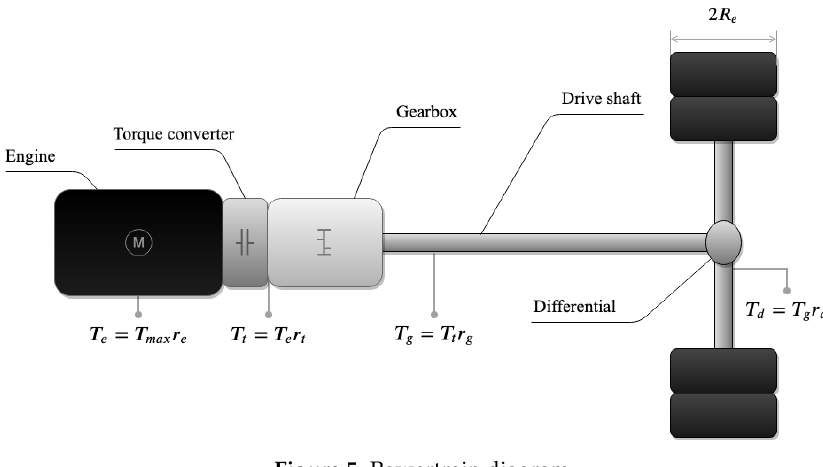
Figure 5. Powertrain